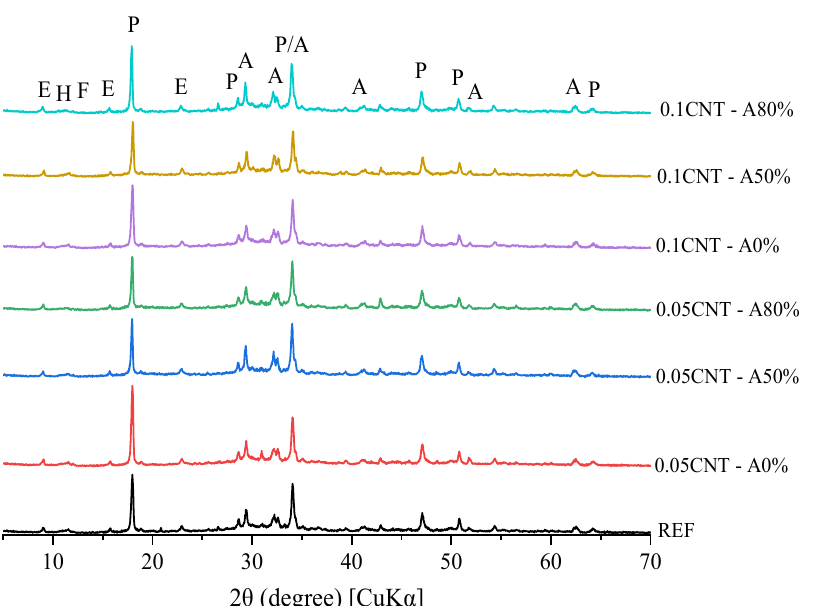
Figure 13. XRD patterns of cement pastes at 28 days of hydration (A—alite; E—ettringite; F—ferrite; H—hemicarbonate; P—portlandite).